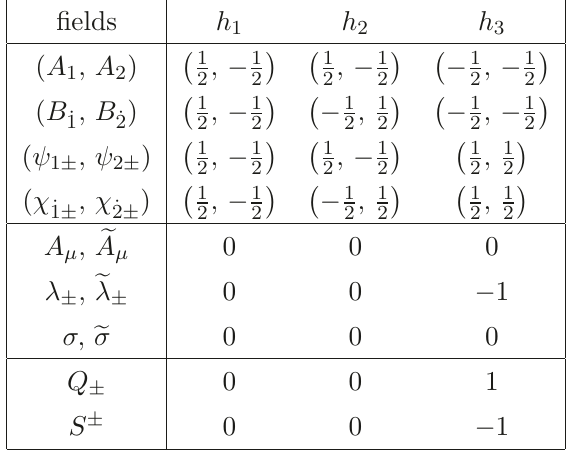
Table 1 . Charges ( h 1 , h 2 , h 3 ) of the